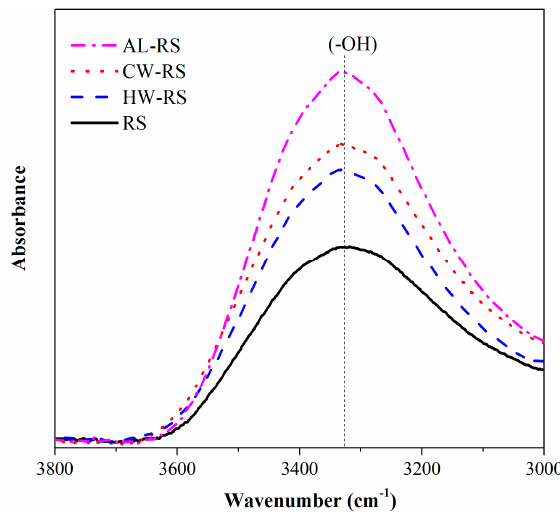
Figure 4. FTIR spectra of the hydroxyl groups of RS, CW-RS, HW-RS and AL-RS.